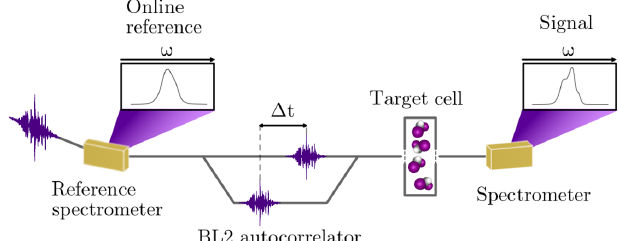
FIG. 1. Sketch of the experimental setup. The incoming FEL spectrum is parasitically measured via the VLS online spectrom- eter [36]. The main beam then passes the FLASH BL2 auto- correlator [35] to split the beam into pump and probe pulses with a variable time delay Δ t between them. These pulses are focused into the interaction volume (target cell, filled with gas-phase di-iodomethane), and the probe transmission spectra are detected as a function of the pump-probe time